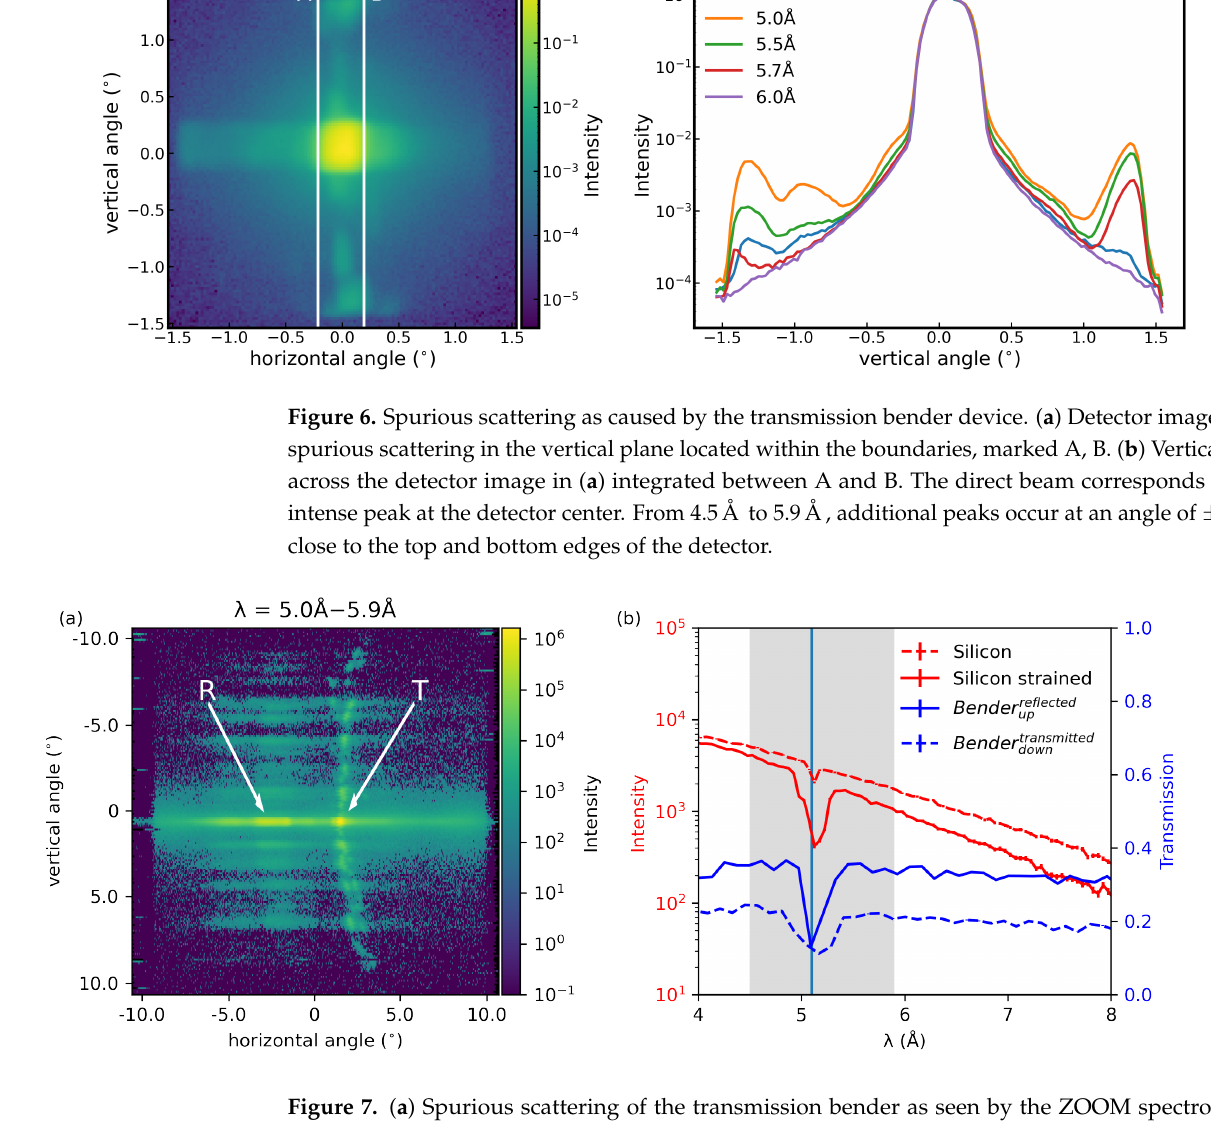
Figure 7. ( a ) Spurious scattering of the transmission bender as seen by the ZOOM spectrometer. The reflected and transmitted beam are indicated by R and T, respectively. ( b ) Spurious scattering from the transmission bender device (blue) and the strained silicon wafers (red), measured at OFFSPEC. The gray shaded area indicates the wavelength range for which the spurious scattering was observed at